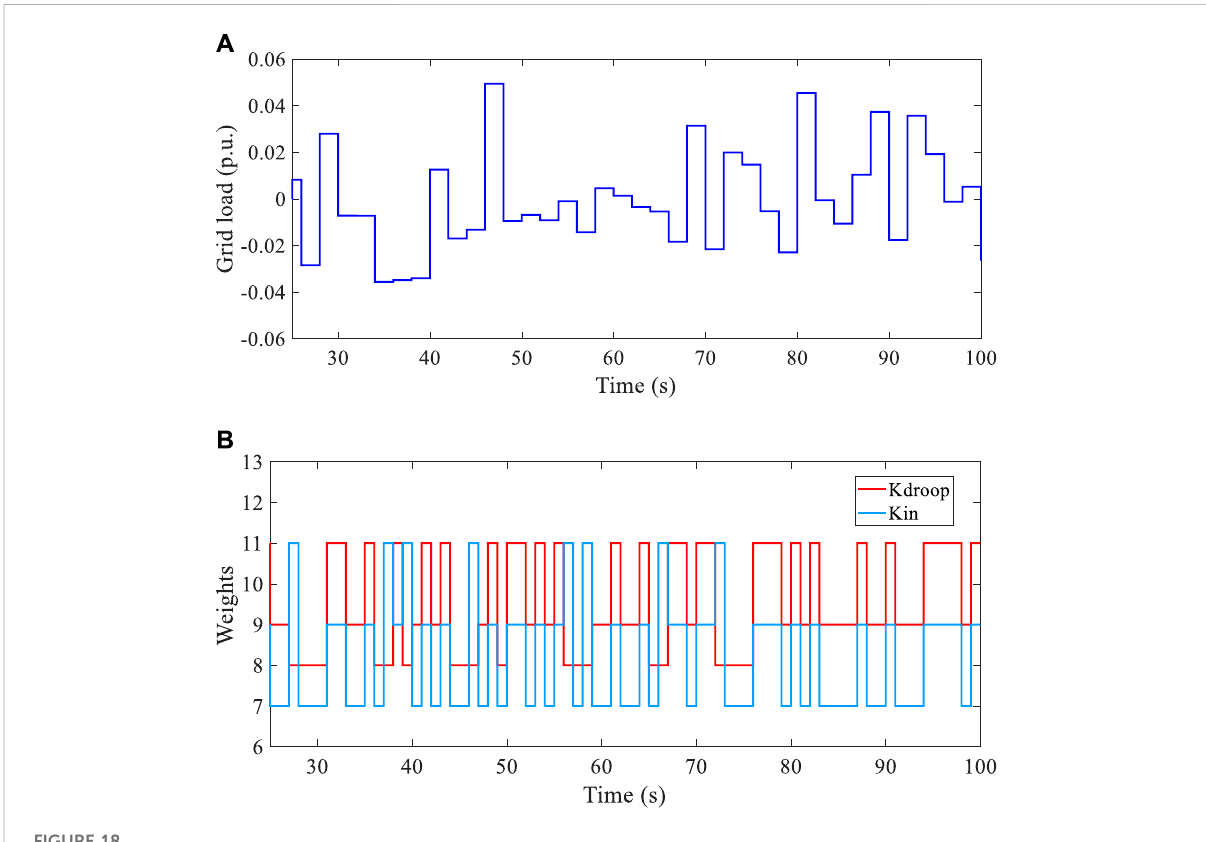
FIGURE 18 Load change from 25 s to 100 s, and K change in the corresponding DSIC scheme. (A) Random system load that changes every 2 seconds. (B) K droop and K in changes for the DSIC scheme when a random white noise system load appears.